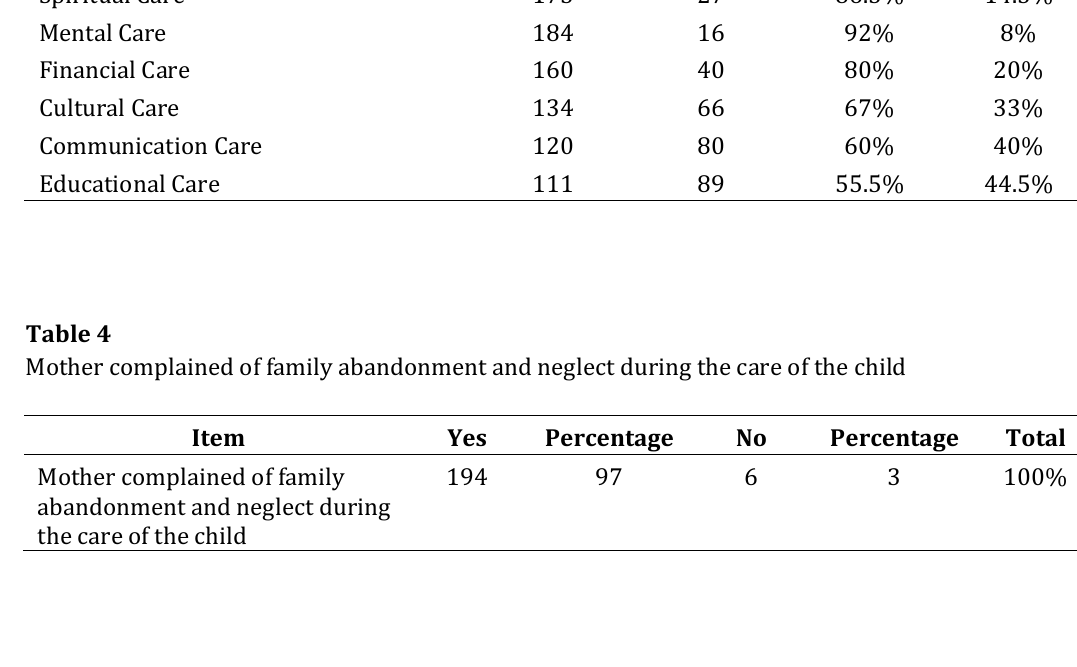
Does mother believe that a child with sickle cell disease cannot live beyond 21years? Item Yes